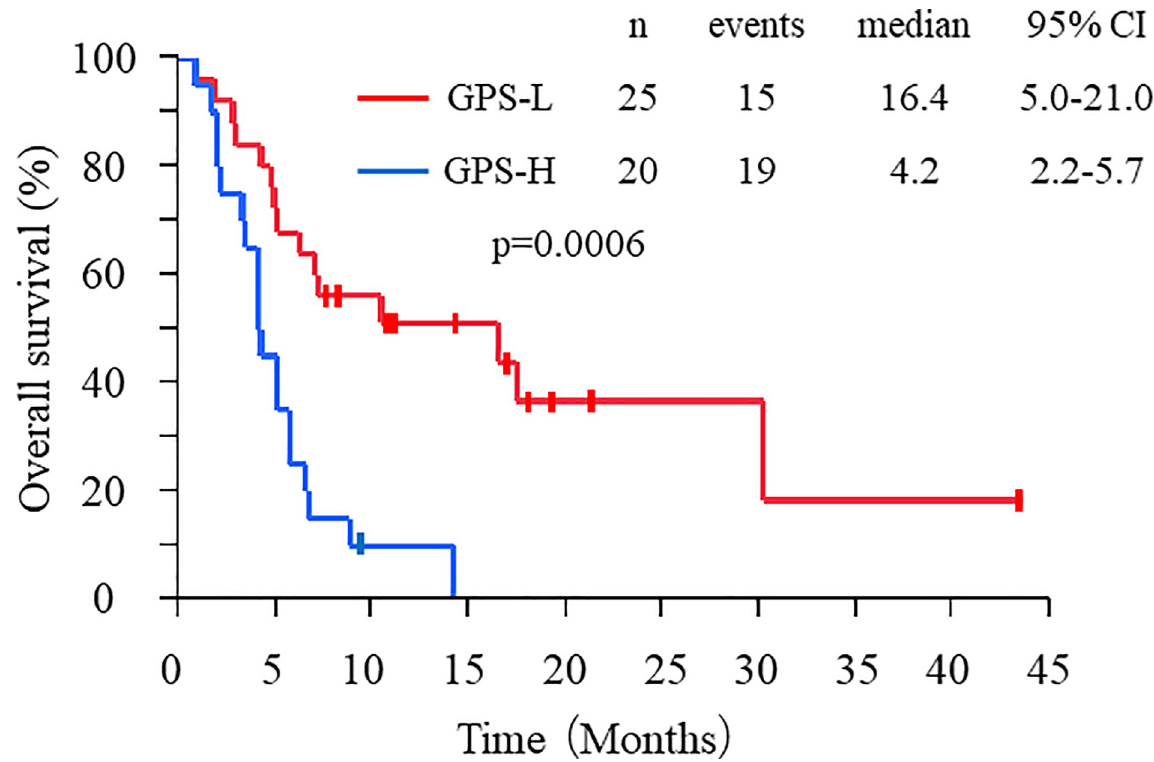
Fig 2. OS of patients sorted by GPS. Kaplan–Meier analysis of OS in GPS-L (red line) and GPS-H (blue line) patients.